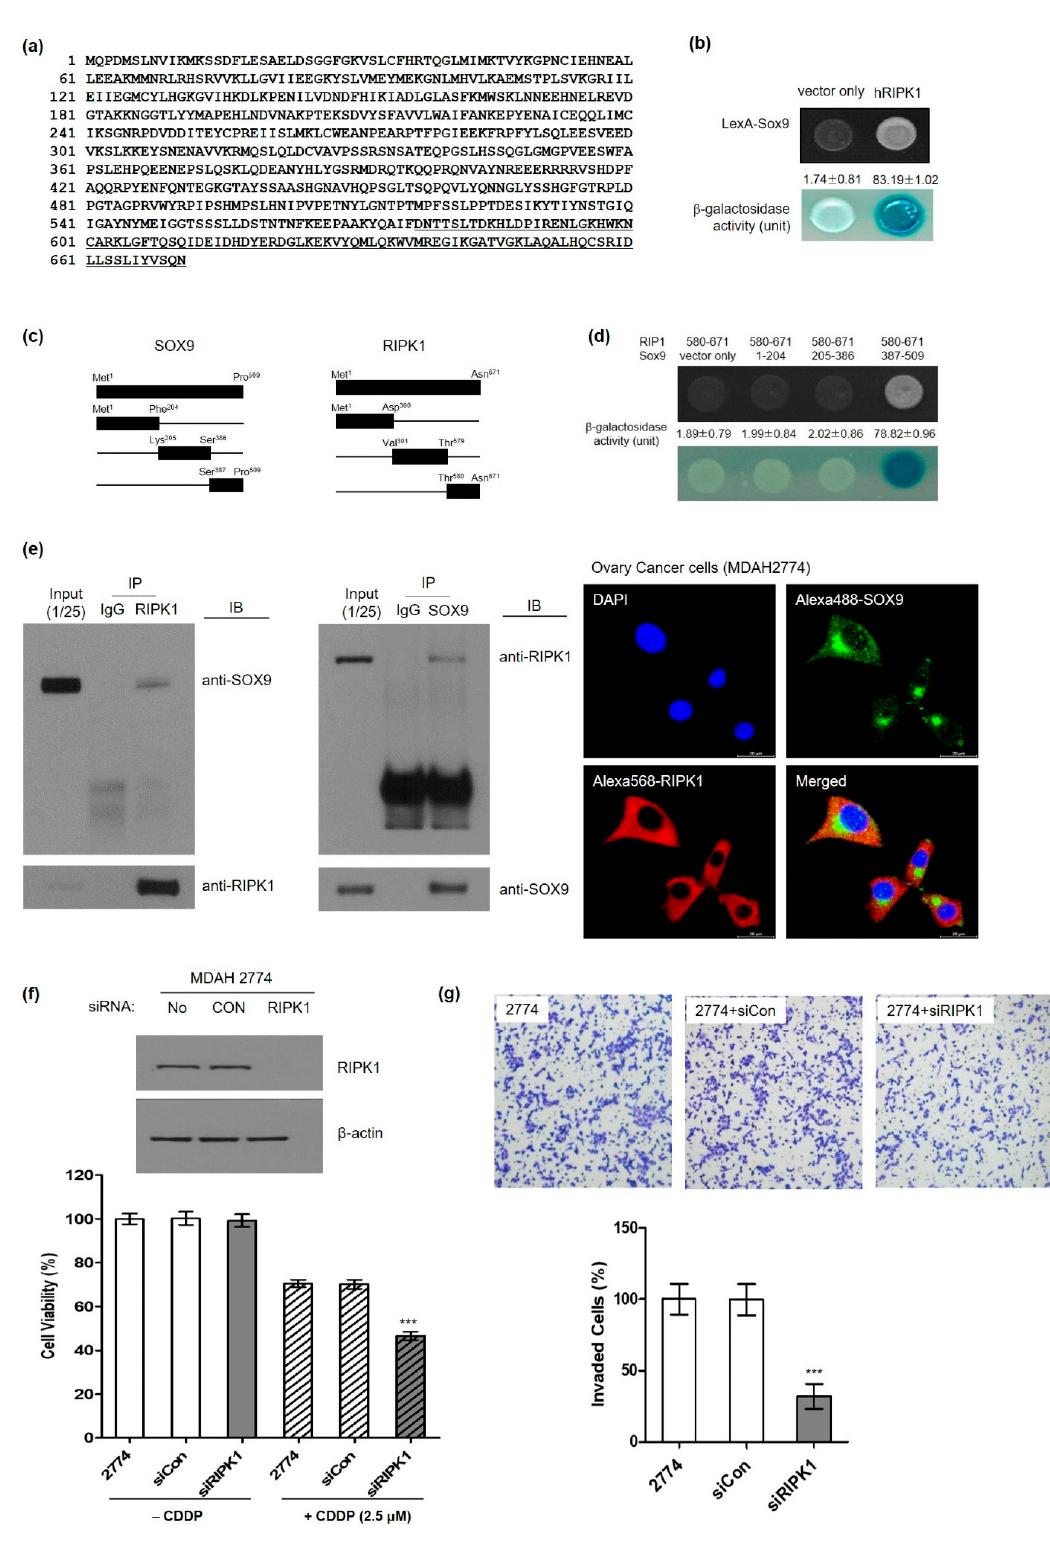
Figure 4. Stem cell factor SOX9 interacts with a cell death regulator RIPK1. ( a ) The amino acid sequence of human RIPK1 is indicated by single-letter abbreviations. The underlined amino acid sequence is the translated hRIPK1 protein identified from the yeast two-hybrid assay. ( b )